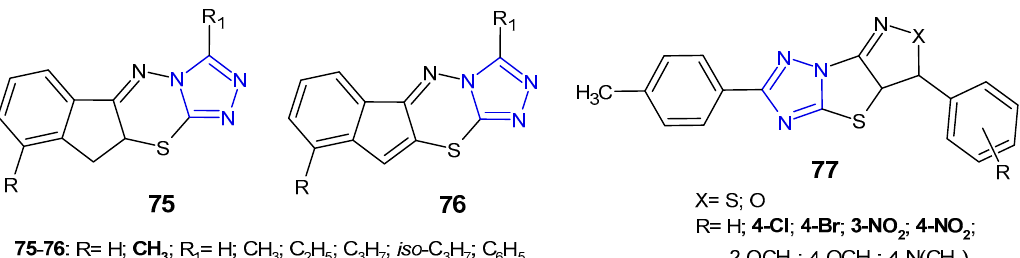
Figure 23. Another fused 1,2,4-triazole derivatives with antibacterial